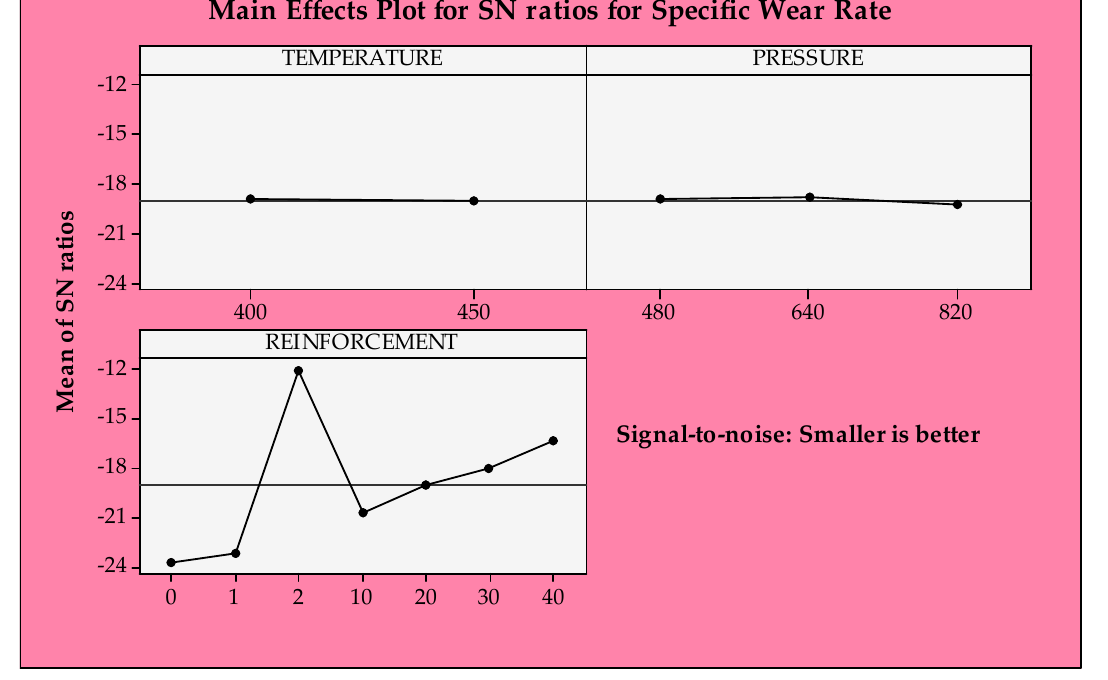
Figure 7. S/N ratios of specific wear rate.